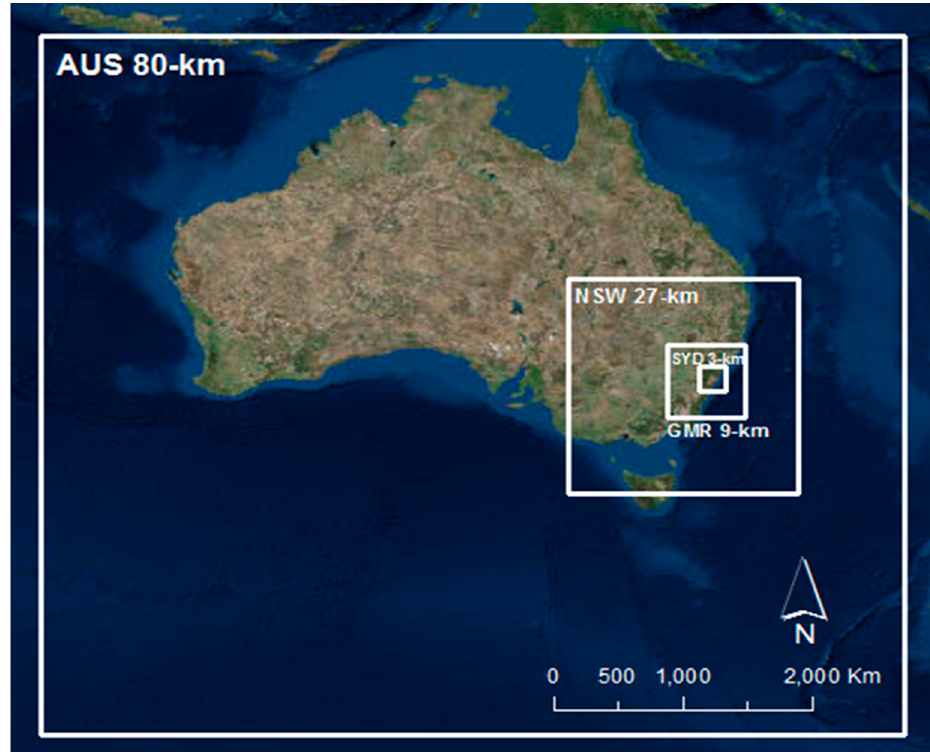
Figure 2. The 4 nested domains for the CCAM-CTM (Cubic Conformal Atmospheric model-Chemical Transport model) simulation: Australia, NSW, GMR (Greater Metropolitan Region) and Sydney domains.